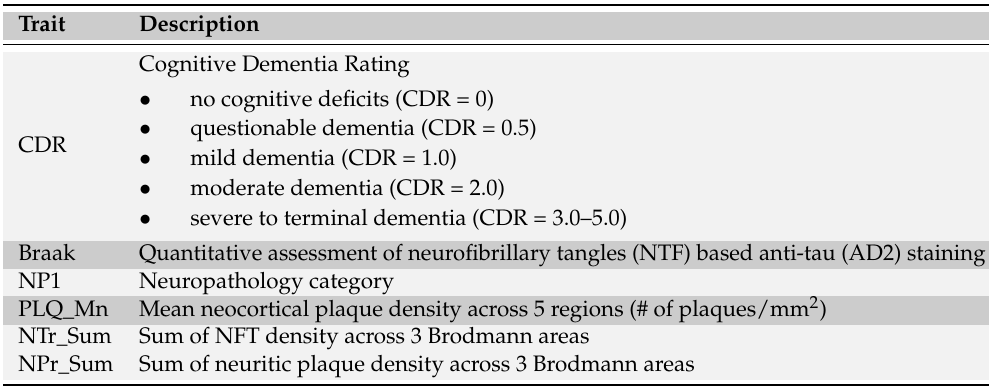
Table 1. Neuropathological